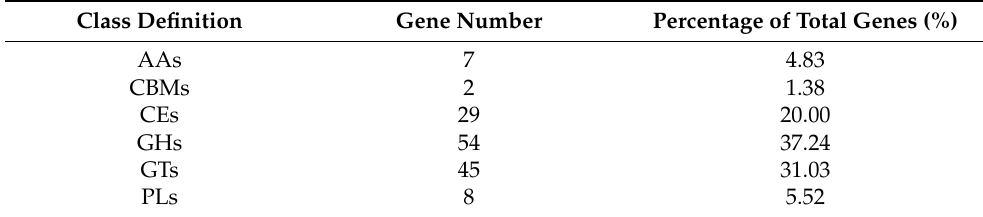
Table 3. CAZyme statistics for the B. subtilis A-5 genome.